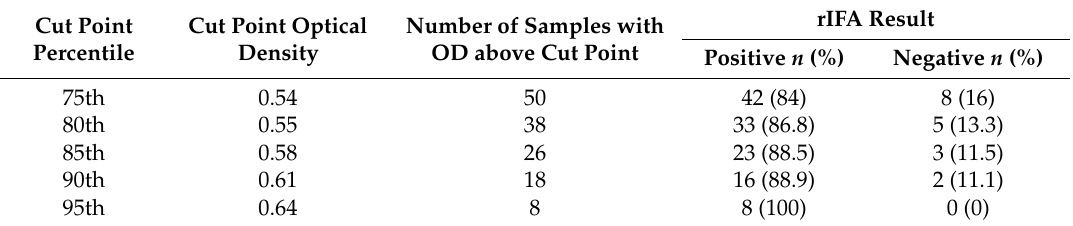
Figure 7. Distribution of optical density values of HCoV-NL63-rIFA-tested human samples. Table 3. Proportions of rIFA positives among the most ELISA reactive human samples by percentile cut